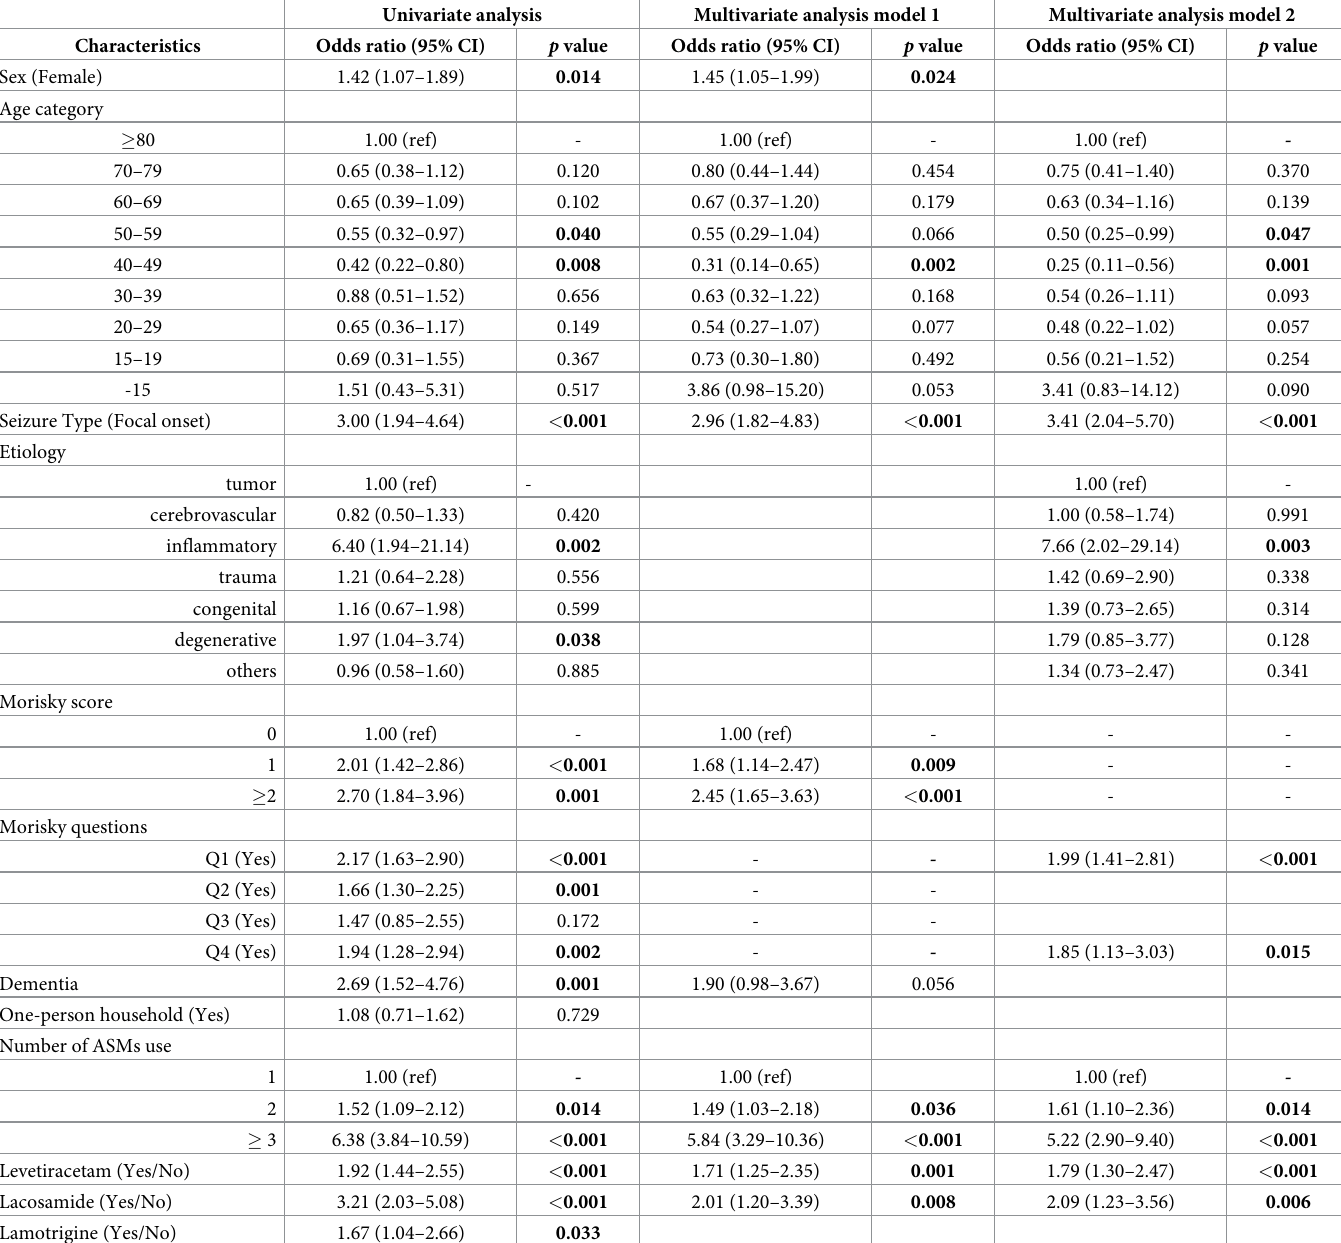
Table 2. The univariate and multivariate logistic regression analyses associated with poorly controlled seizures in all